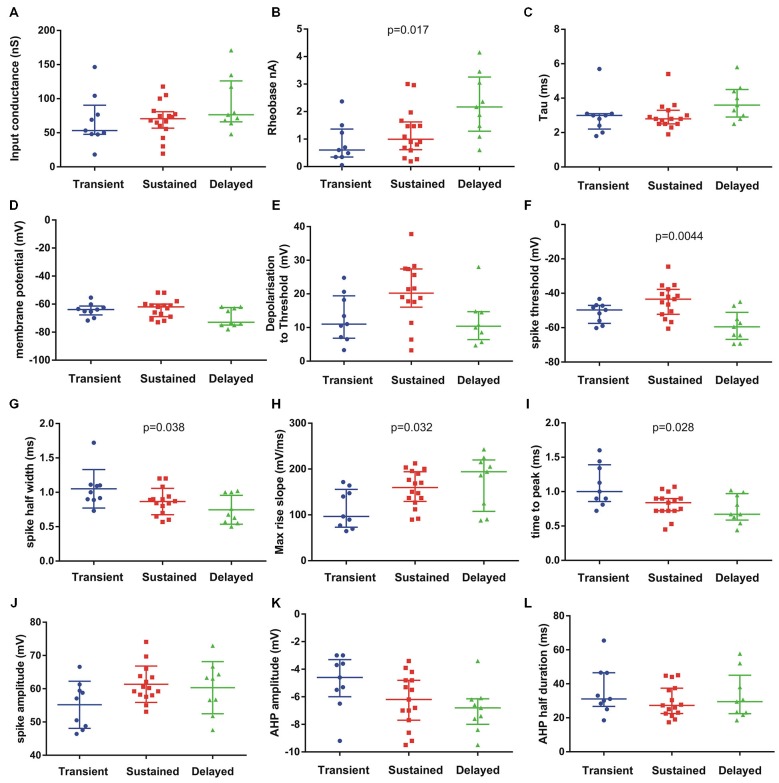
Passive and active electrical properties of postnatal mouse lumbar motoneurons (n = 33) in three subgroups defined by their discharge firing pattern. Fourteen electrical properties were compared (12 illustrated). Among them, several electrical properties show significant differences in the medians as indicated on each graph (Kruskal–Wallis test). The delayed subgroup has the highest conductance (A) rheobase (B) and time constant (C) suggesting they represent the largest motoneurons. The resting membrane potential (Em) (D) was hyperpolarized in this subgroup (delayed) but the spike voltage threshold was the lowest (F). The spike voltage threshold and the depolarization to threshold were the highest in the sustained subgroup (E,F). The AP was the shortest in the delayed population (half width in G) and the fastest (H,I) compared to the two others groups. The AP amplitude was similar in sustained and delayed subgroups but lower in the transient group (J). The AHP amplitude was smaller in the transient subgroup and larger in the delayed subgroup (K) whereas the medians of AHP half durations were comparable in the three subgroups (L). Bars indicate median and quartile. Statistical significance for three populations: Kruskal–Wallis exact test.